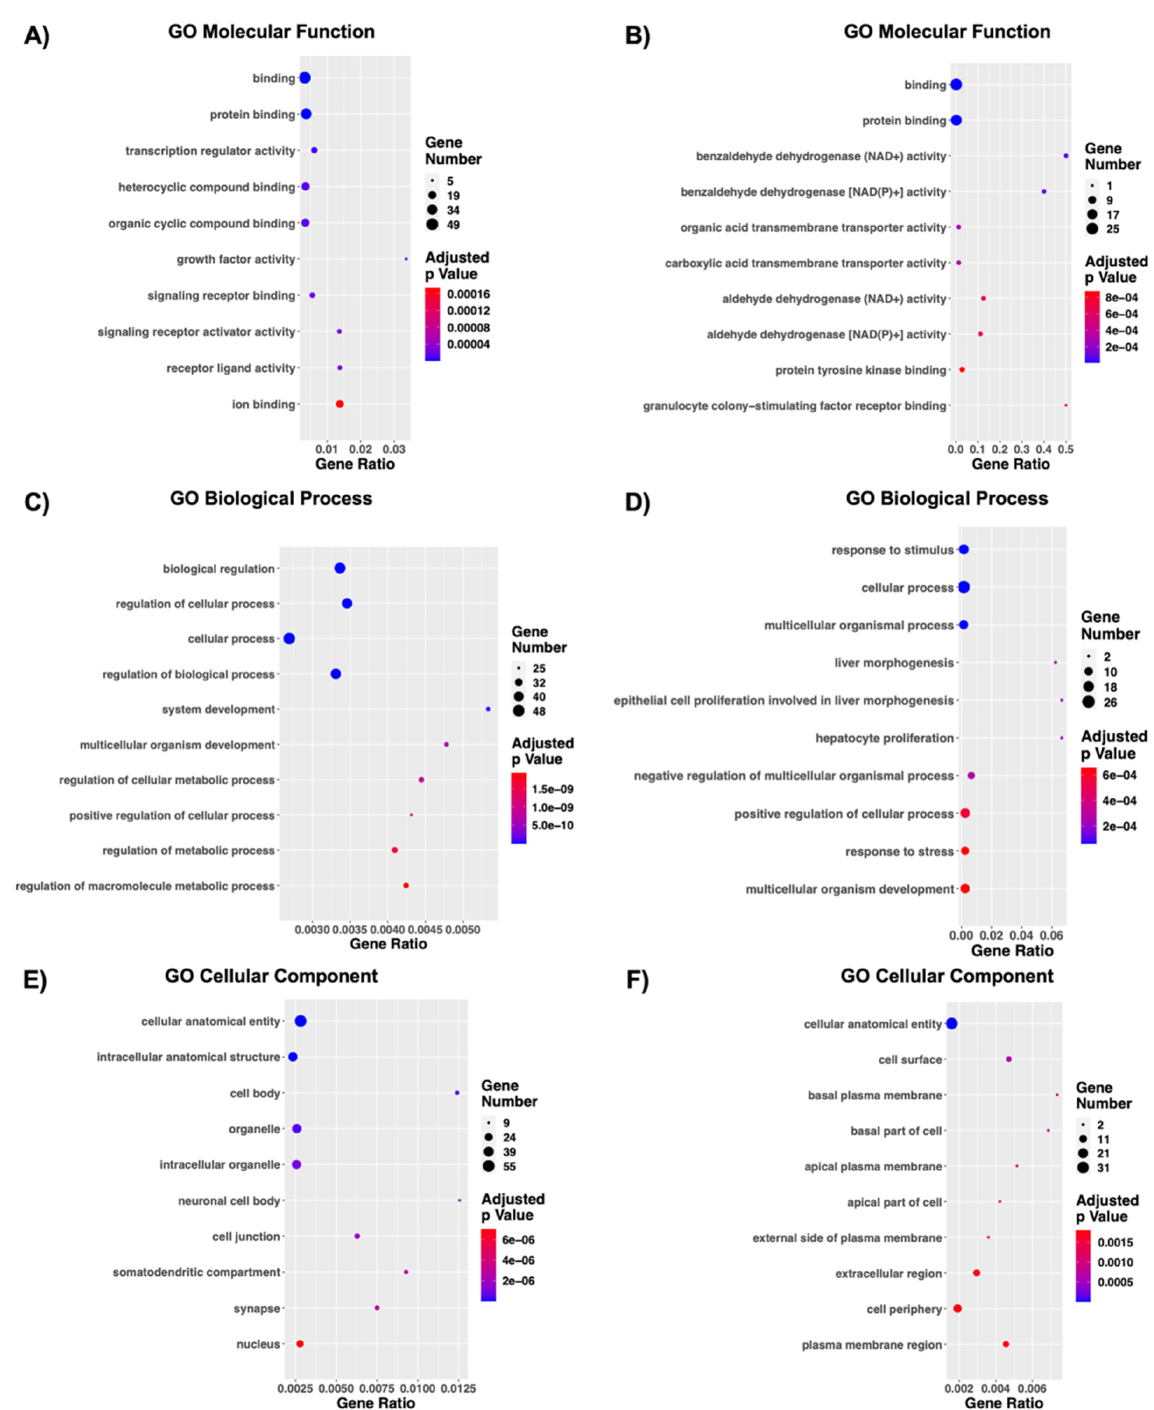
Figure 4. GO enrichment analysis of co-expression modules. On the basis of the turquoise and blue modules we performed a functional enrichment analysis via the g:Profiler web tool by ranking genes according to |log 2 FC|. The top 10 deregulated pathways according to their significance are displayed. A significant deregulation was observed in GO categories, which include BP, MF, and CC. GO MF ( A , B ) highlighted respectively 184 significantly deregulated pathways for the turquoise module and 174 for the blue one. GO BP ( C , D ) highlighted 1428 pathways emerged as significantly deregulated for the turquoise module and 1193 for the blue one. GO CC ( E , F ) highlighted 130 significant terms from turquoise module and 73 form the blue one. The y -axis represents the name of the pathway, the x -axis represents the Rich factor, dot size represents the number of different genes, and the color indicates the adjusted p -value.